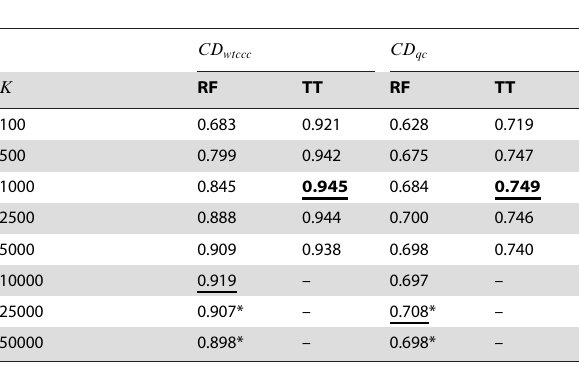
Table 1. Comparison between the two methods.